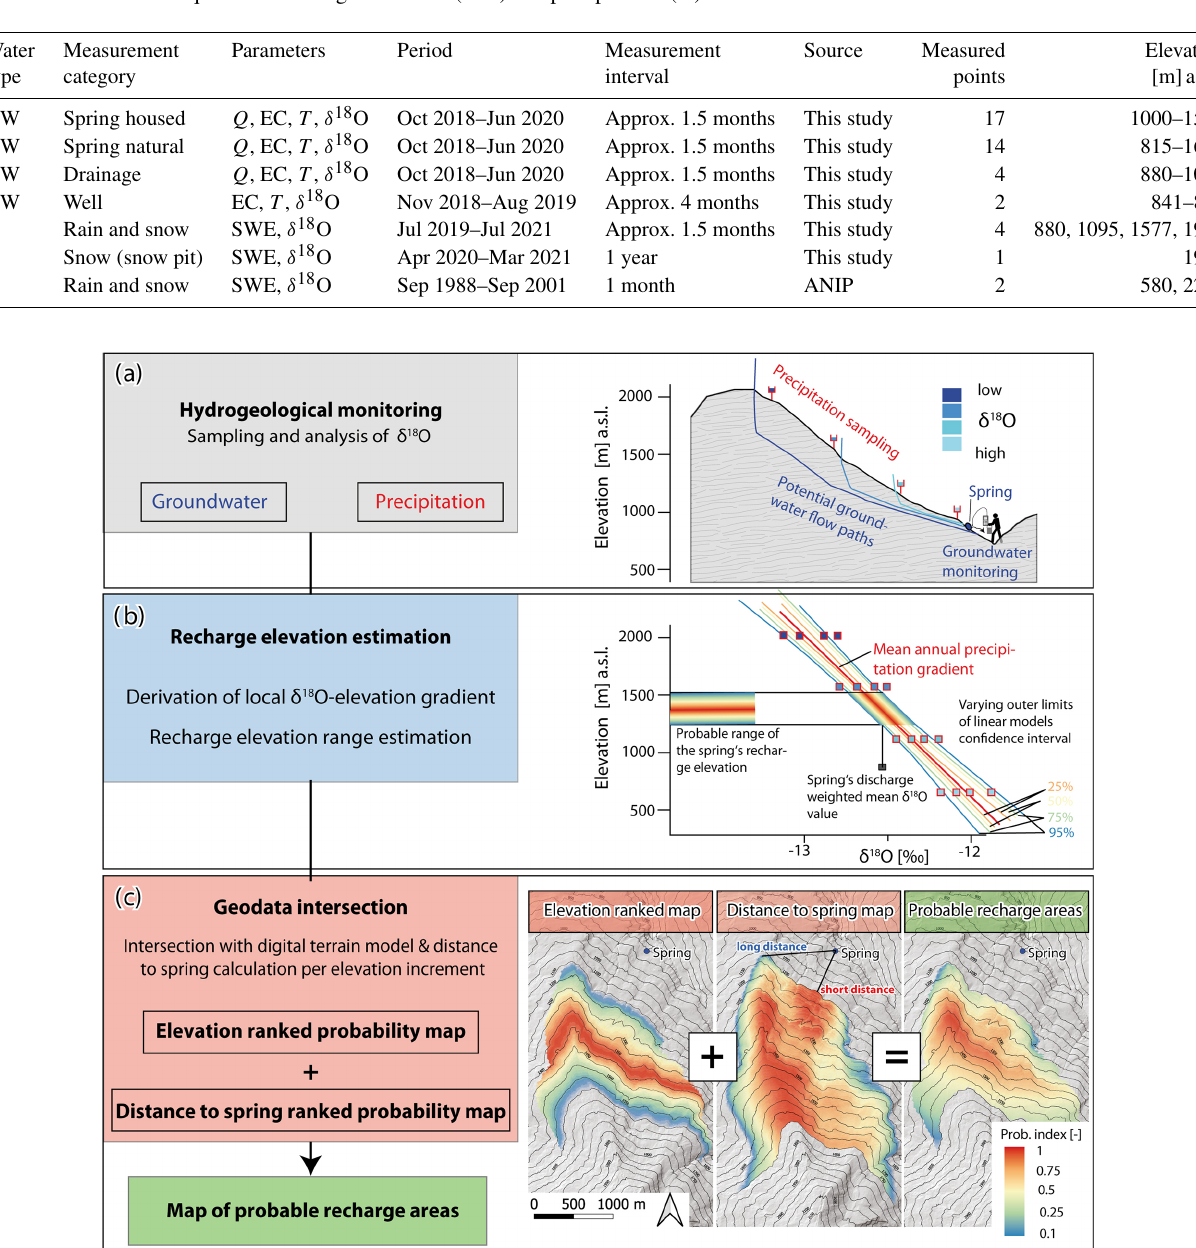
Table 1. Overview of acquired and used groundwater (GW) and precipitation ( P ) data.